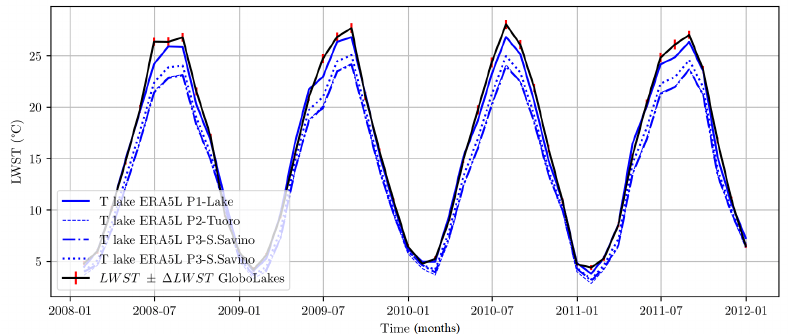
Figure 5. Comparison for the period 2008-2011 between the lake surface water temperature, LSWT ( ◦ C) from satellite (reported in black), and the mixed layer temperature, T ML ( ◦ C), as modeled by ERA5L (in blue), for each ERA5L point and their weighted